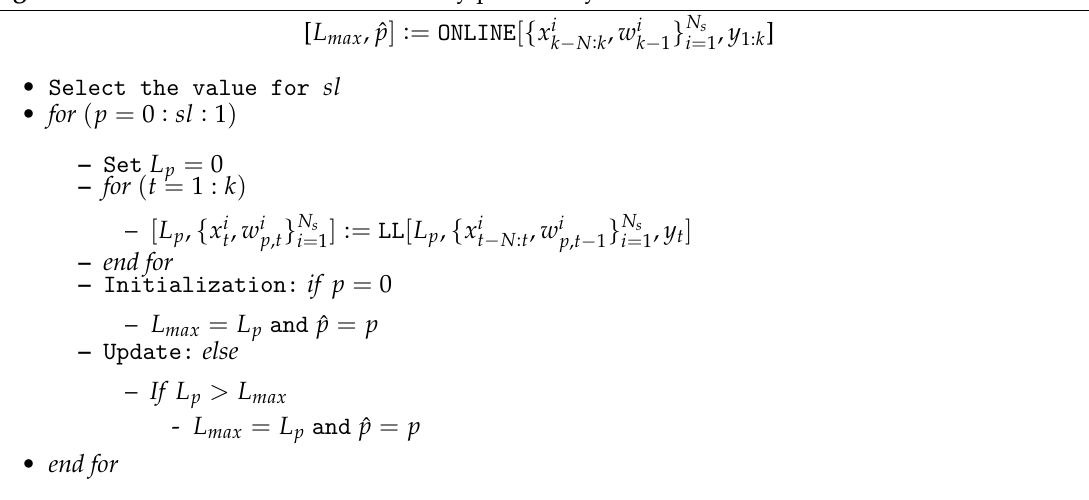
Algorithm 4 Online identification of latency